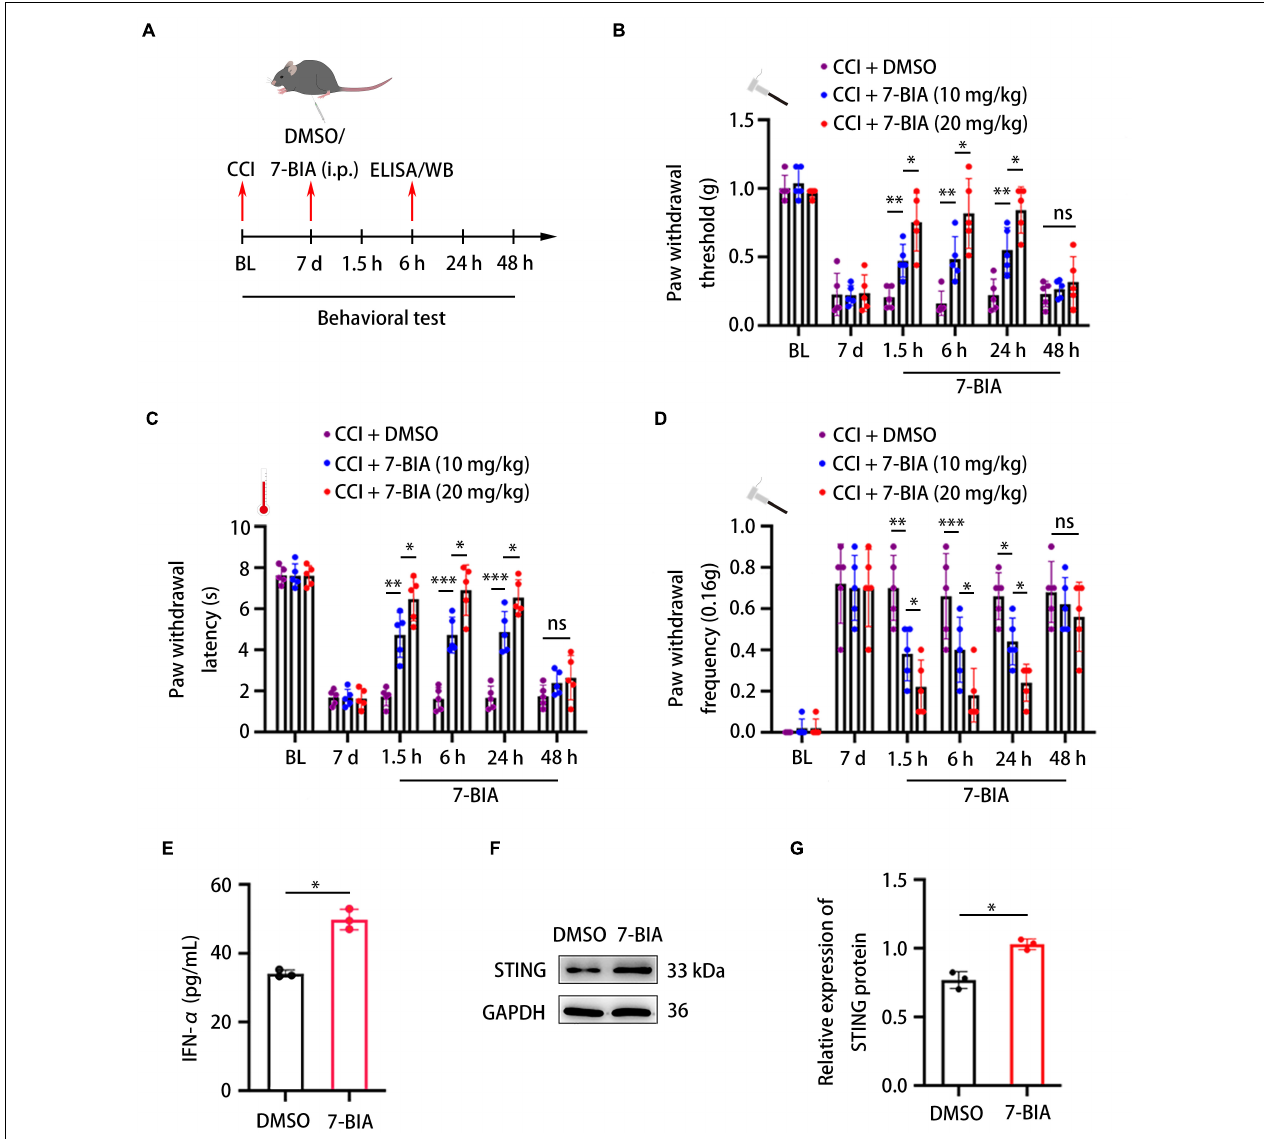
FIGURE 6 | Protein tyrosine phosphatase receptor type D inhibitor 7-BIA alleviates neuropathic pain in mice following CCI. (A) Schedule of surgery, 7-BIA treatment (10 or 20 mg/kg, i.p.), behavioral testing, ELISA, and Western blotting. (B–D) Paw withdrawal threshold, paw withdrawal latency, and paw withdrawal